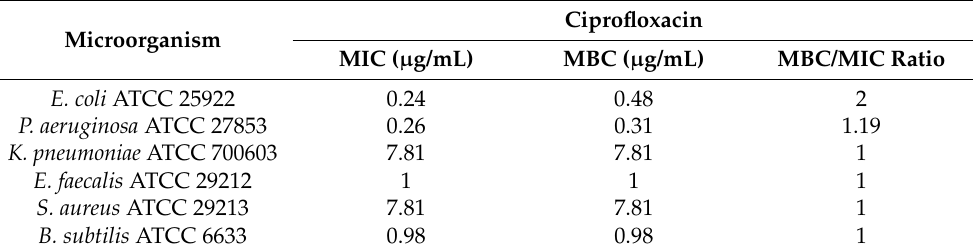
Table 5. MIC ( µ g/mL), MBC ( µ g/mL), and MBC/MIC ratio of ciprofloxacin towards reference Gram-positive and Gram-negative bacterial